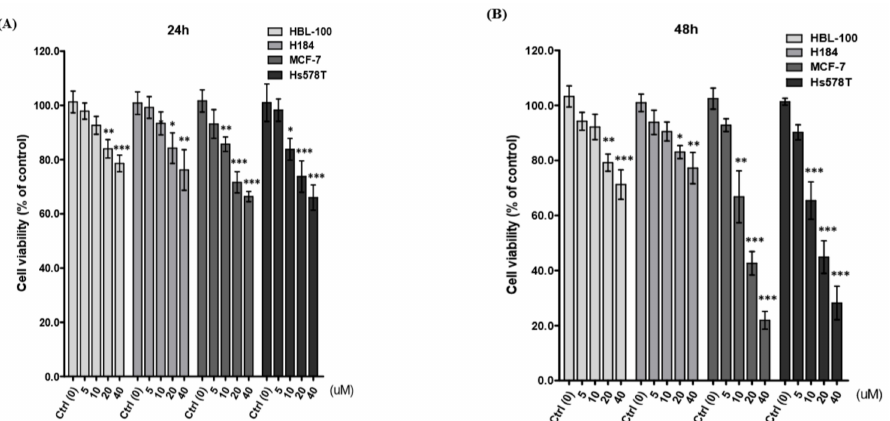
Figure 1. E ff ect of diosgenin on the growth of breast cancer cells. Human breast cancer MCF-7 and Hs578T cells, and normal mammary epithelial HBL-100 and H184B5F5 / M10 cells, were incubated with the indicated concentrations of diosgenin for ( A ) 24 and ( B ) 48 h. Growth inhibition of cells by diosgenin was assessed by the MTT assay. Results are presented as percentages of viable diosgenin-treated cells relative to control cells (Ctrl, 0 µ M). Data are shown as means ± SD from four independent experiments (each in triplicate). The viability of control cells is defined as 100%. * p < 0.05, ** p < 0.01, and *** p < 0.001 vs. control (Ctrl)